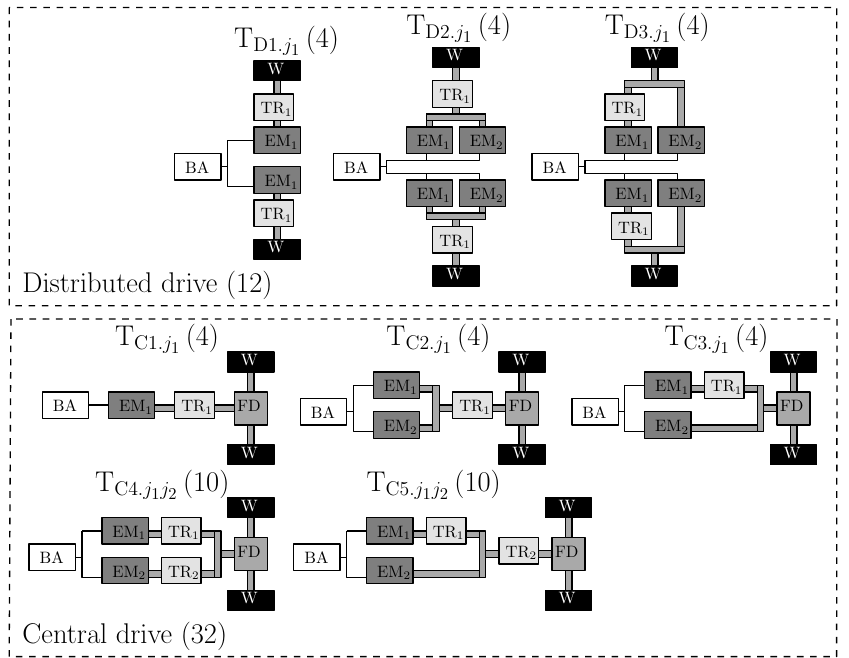
Figure 2. Set of eight different feasible powertrain topologies studied, classified into distributed and central drive systems. The first subscript ( i ) indicates the topology name; the second subscript after the dot ( j l ) indicates the total number of gears in the gearbox. For each topology, different gearbox types are considered, resulting in a set of in total 44 powertrain configurations studied. W = driven